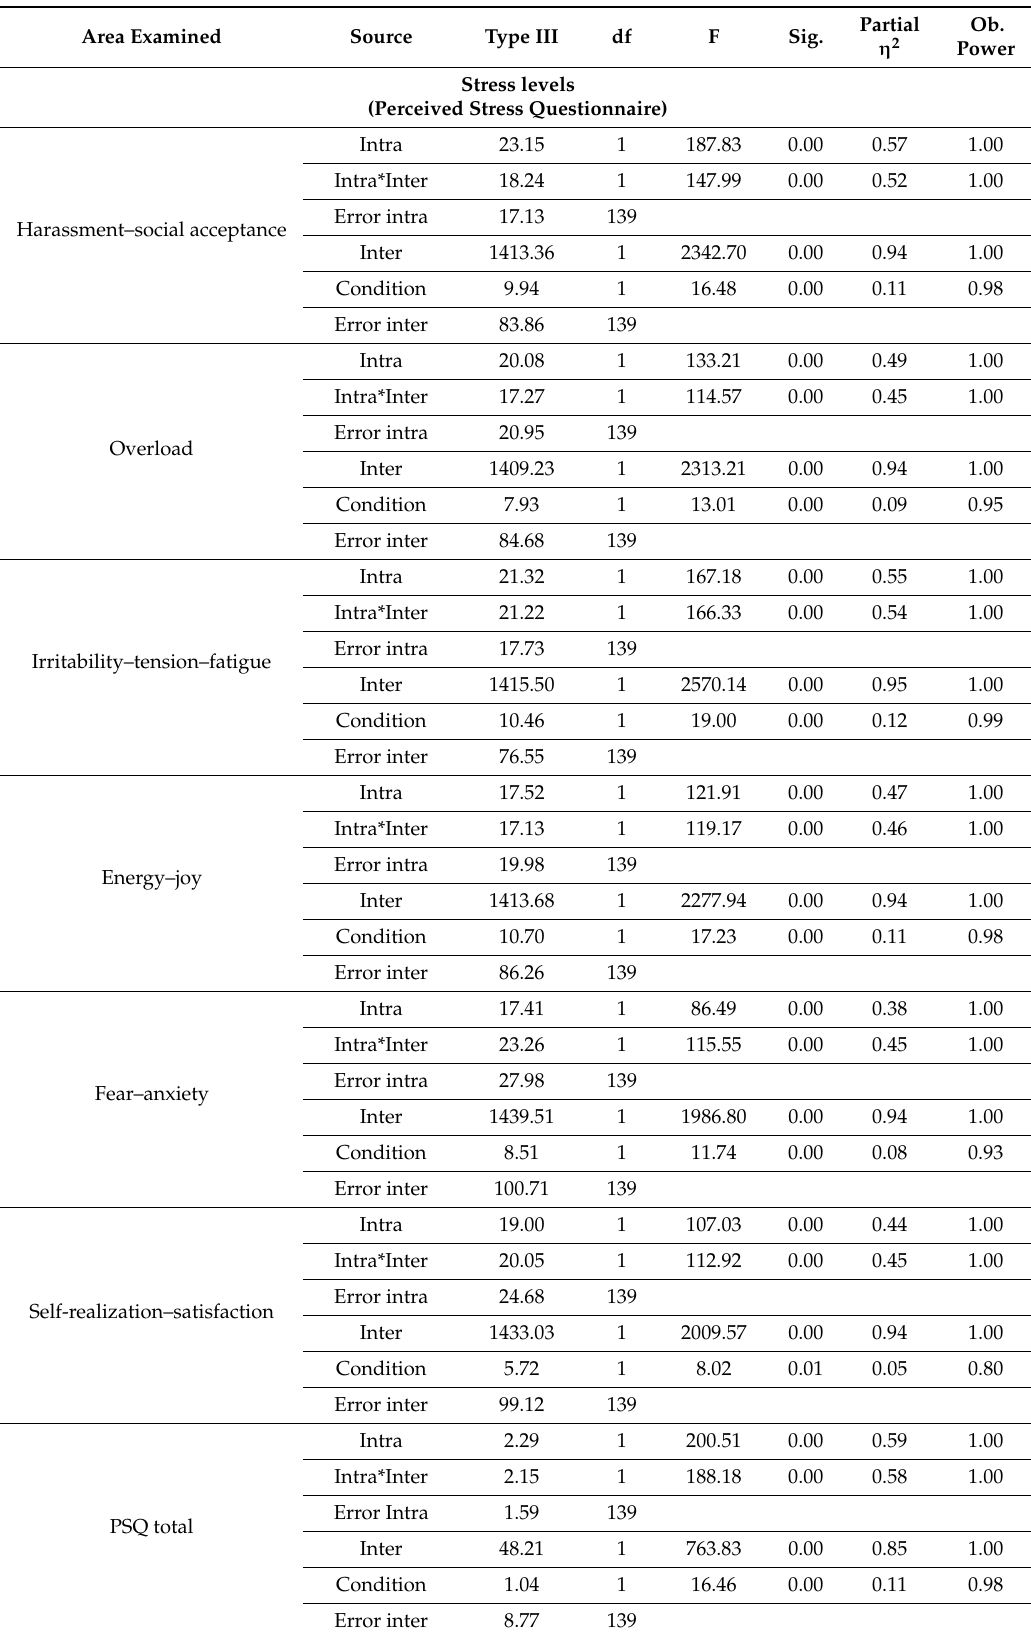
Table 3. Results of intra- / intersubject univariate